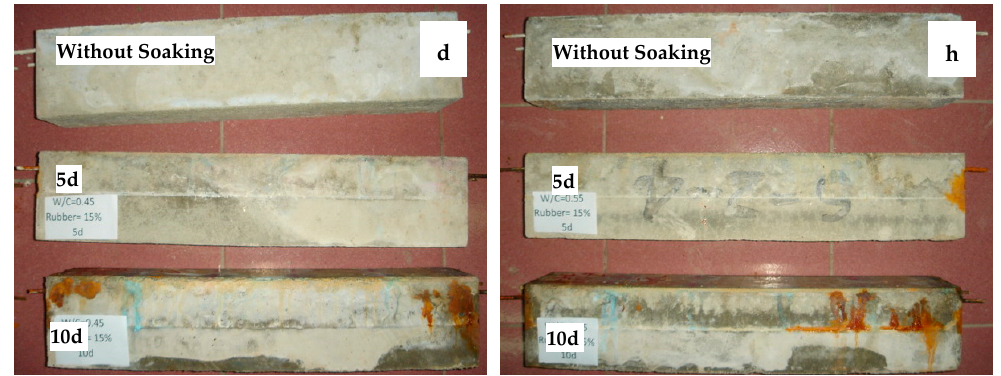
Figure 3. Test specimen after rebar corrosion: ( a ) Reference concrete, W/C = 0.55; ( b ) 50 kg/m 3 rubber aggregate concrete, W/C = 0.55; ( c ) 100 kg/m 3 rubber aggregate concrete, W/C = 0.55; ( d ) 150 kg/m 3 rubber aggregate concrete, W/C = 0.55; ( e ) Reference concrete, W/C = 0.45; ( f ) 50 kg/m 3 rubber aggregate concrete, W/C = 0.45; ( g ) 100 kg/m 3 rubber aggregate concrete, W/C = 0.45 and ( h ) 150 kg/m 3 rubber aggregate concrete, W/C = 0.45.